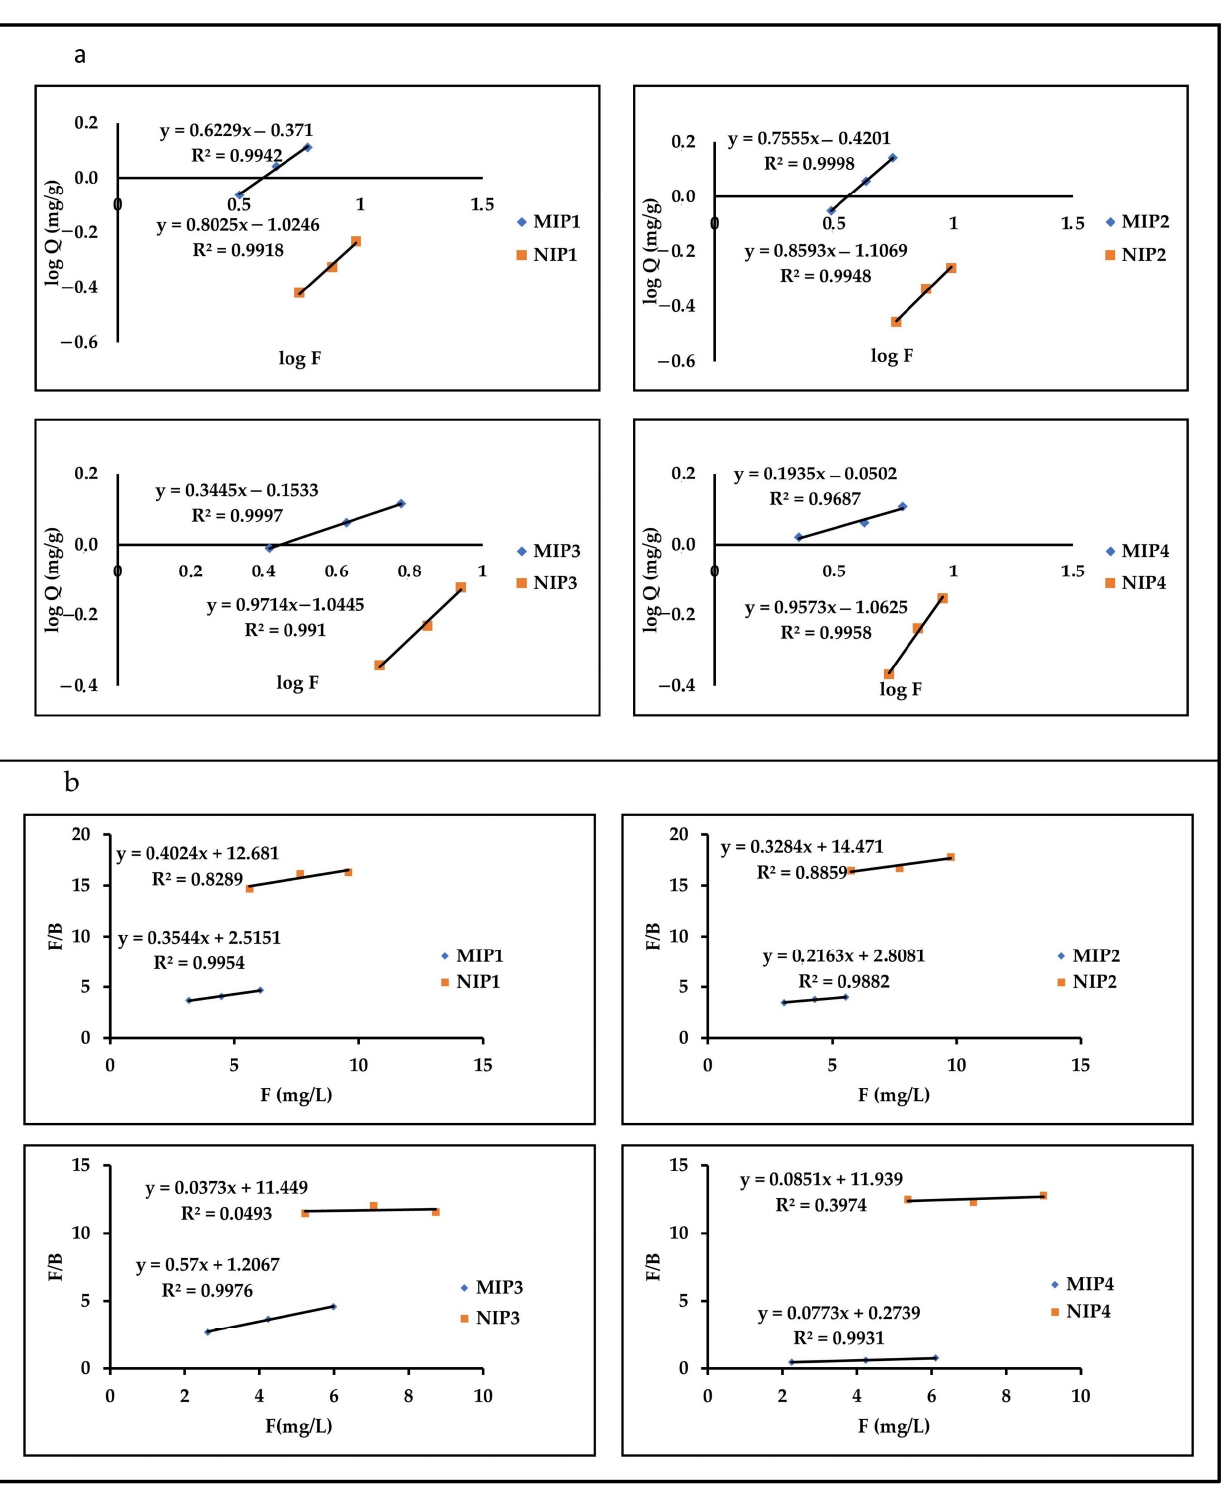
Figure 4. Fitting the adsorption of MIP and NIP to isotherm adsorption model, Freundlich ( a ) and Langmuir ( b Langmuir ( b ).